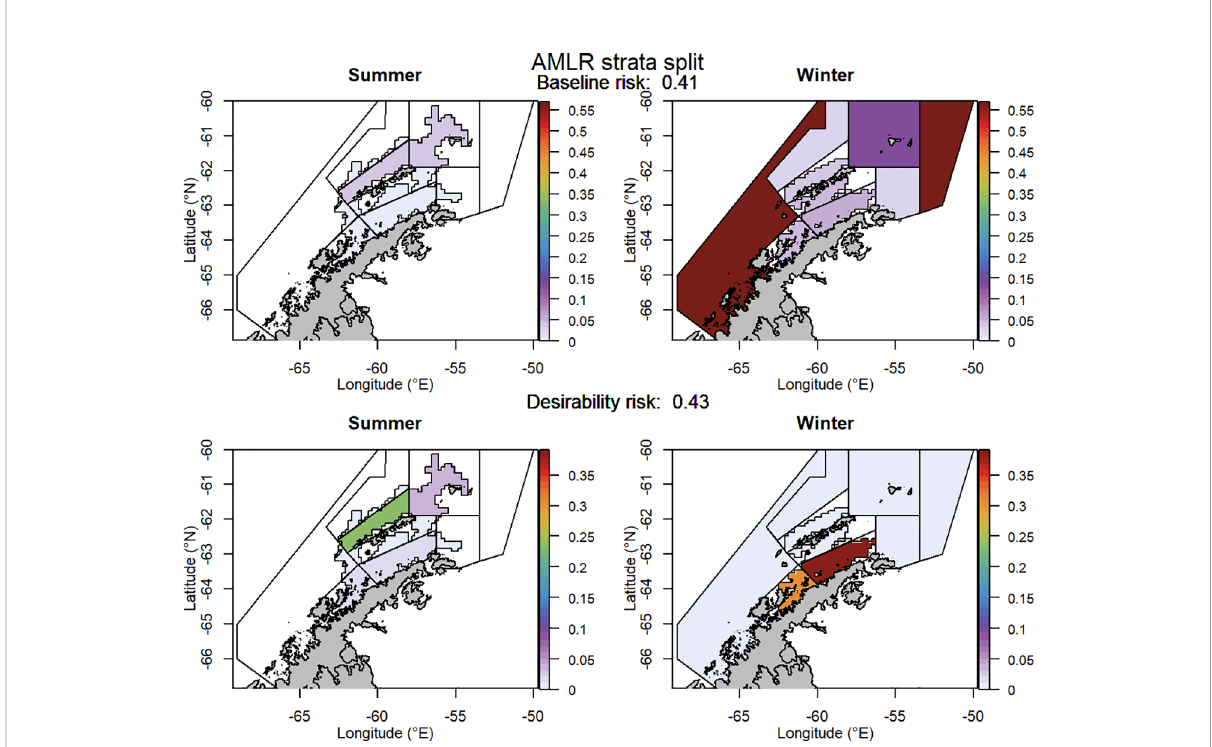
FIGURE 7 The proportion of the annual krill catch limit that could be taken from each management unit (delineated using the US-AMLR survey strata divided into smaller management units) during summer and winter when the risk assessment was implemented after the winter krill layer was adjusted and assuming catch is not evenly distributed within management units. Values sum to 1 across all management units and for both seasons for each of the baseline (upper panel) and desirability (lower panel)